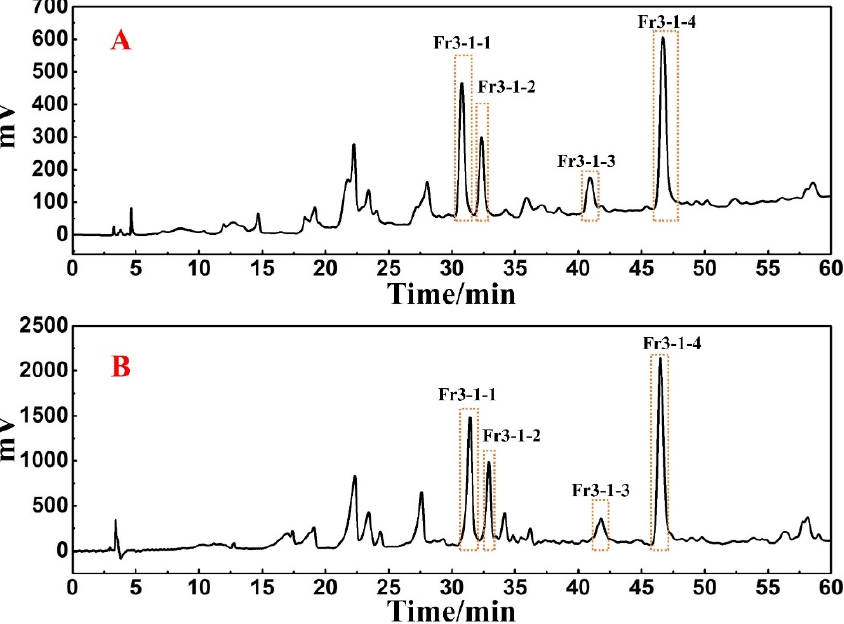
Figure 5. ( A ) Analysis chromatogram of Fr3-1 on a Click XIon analytical column. ( B ) Preparative chromatogram of Fr3-1 on a Click XIon preparative